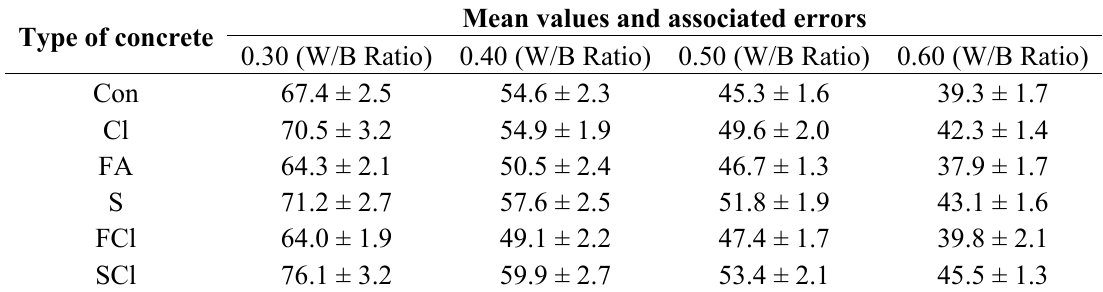
Table 2. Tensile splitting strength of concrete at 28 days (mean values and associated errors). Type of